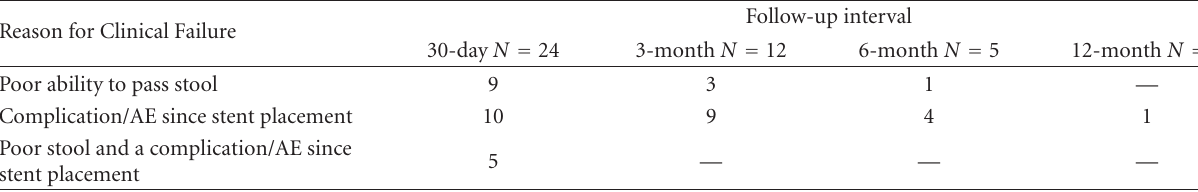
Table 2: Factors contributing to clinical failure.